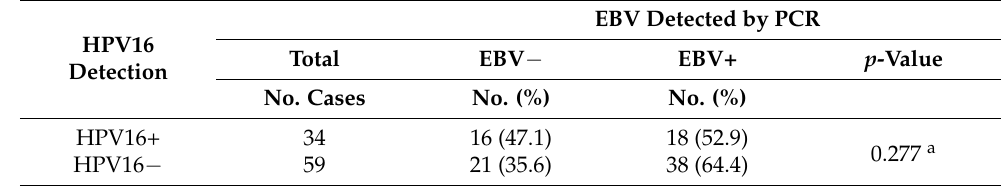
Table 4. Frequency of HPV16/EBV coinfection in cervical